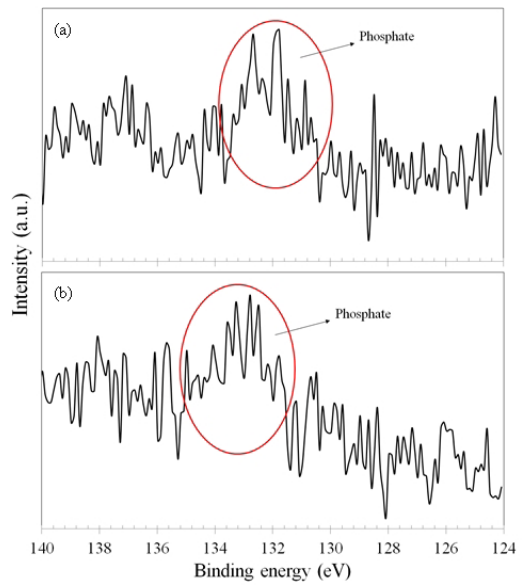
Figure 9. XPS P 2p high resolution spectra of the AZ61 alloy anodized in the phosphate-containing electrolyte: (a) PHO-20; b) PHO-30.